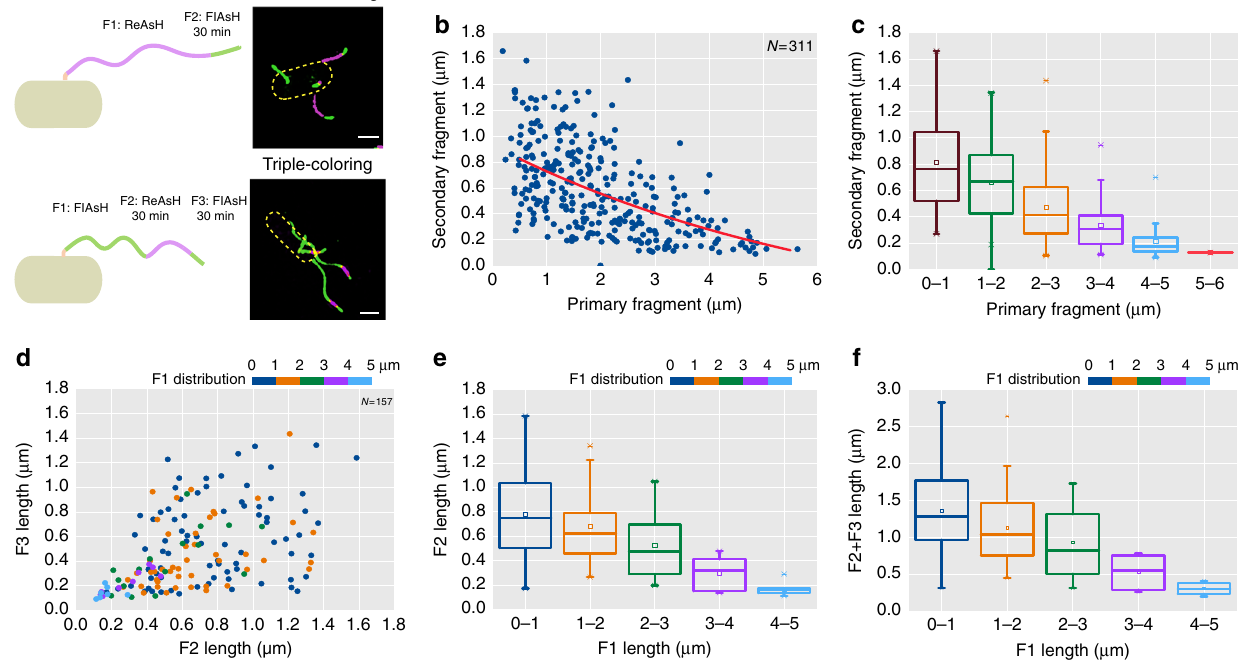
Fig. 2 Flagellar growth rate measurements using super-resolution imaging. a Examples of TC tag inserted fl agella labeled by double- and triple-color labeling. The secondary (F2) and tertiary (F3) segments were grown for 30 min, respectively. Scale bar = 1 µ m. b Plot of lengths of secondary versus primary segments (F1) for double-color labeling, fi tted by an exponential line with mean values taken from c . A total of 311 fl agella were measured and analyzed. c Box plot of the data from b in which 1 µ m was set as the bin size value, showing that fl agellar growth rate decreases with increasing fl agellar length (center line, median; center square, mean; box limits, upper and lower quartiles; whiskers, ×1.5 interquartile range). d Relation between the lengths of secondary and tertiary segments. Overall, 157 individual fl agella were measured and divided into 5 groups, as indicated by colors according to the lengths of primary segments. e , f Box plots of secondary and secondary plus tertiary segments according to the length of F1 from d ,